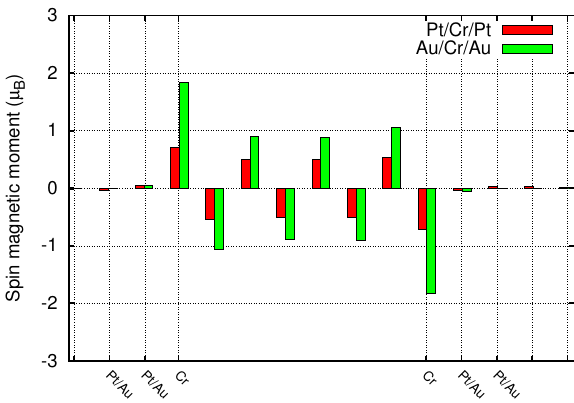
Figure 2. Spin magnetic moments along the junction constituted by Pt or Au leads and eight layers of